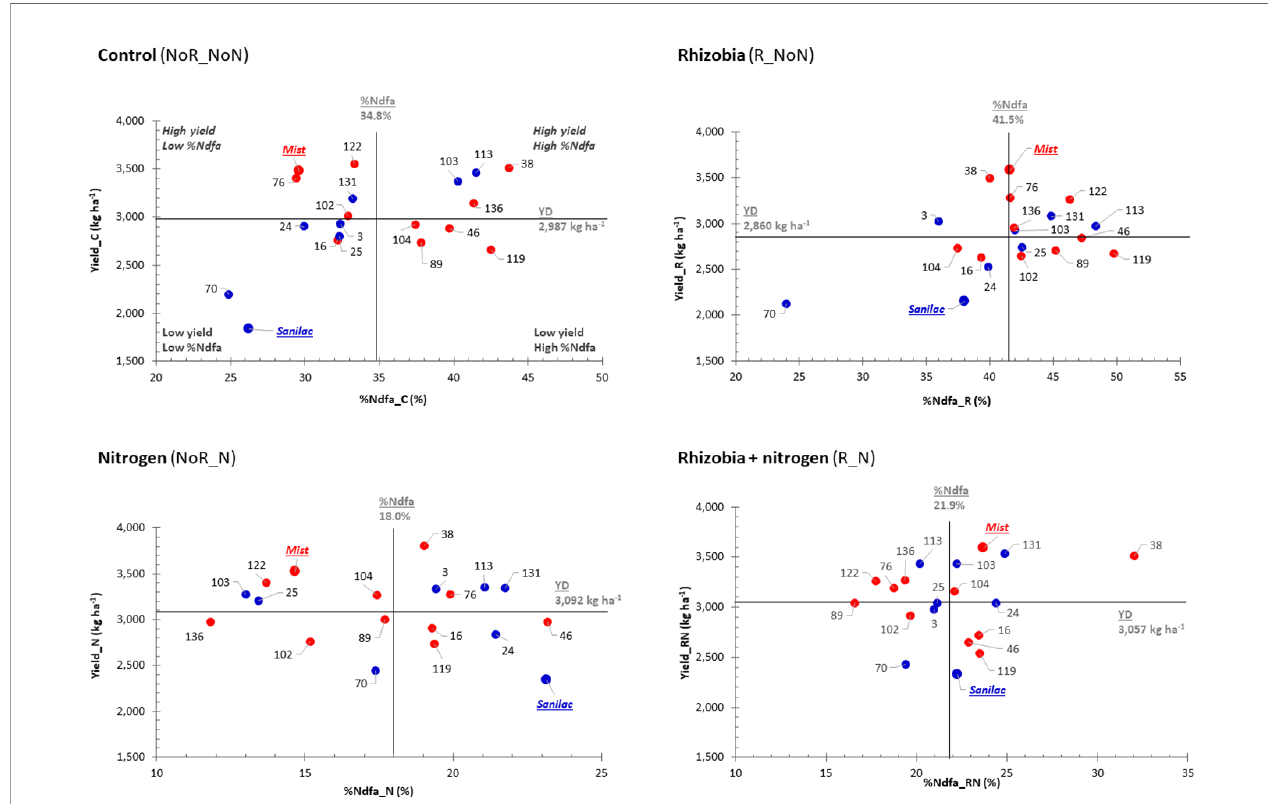
FIGURE 3 | Selection of high-yielding common bean genotypes having a high percentage of nitrogen derived from atmosphere (%Ndfa) in 2016 pilot study. Plots of yield and %Ndfa for 20 bean genotypes in control (C treatment, NoR_NoN), nitrogen (N treatment, NoR_N), rhizobia (R treatment, R_NoN) and combined application of nitrogen fertilizer and rhizobia inoculation (RN treatment, R_N) evaluated at the Elora research station, ON in the 2016 experiment. Plots are divided into four quadrants based on the yield and %Ndfa mean values (black lines): genotypes at the top right quadrant are best performing [they are both high yielding and good nitrogen fi xers (%Ndfa)]; genotypes at the top left quadrant are high yielding but low nitrogen fi xers; genotypes at the bottom left quadrant are low yielding and low nitrogen fi xers; and, genotypes at the bottom right quadrant are low yielding but have good nitrogen fi xing abilities. Genotypes: Mist (red, italic), SNF parent (high yield under SNF condition) and 10 SNF-dependent (high yield under SNF condition) RILs (red) and Sanilac (blue, italic), N parent (high yield under nitrogen fertilizer) and seven N-dependent (high yield under nitrogen fertilizer) RILs